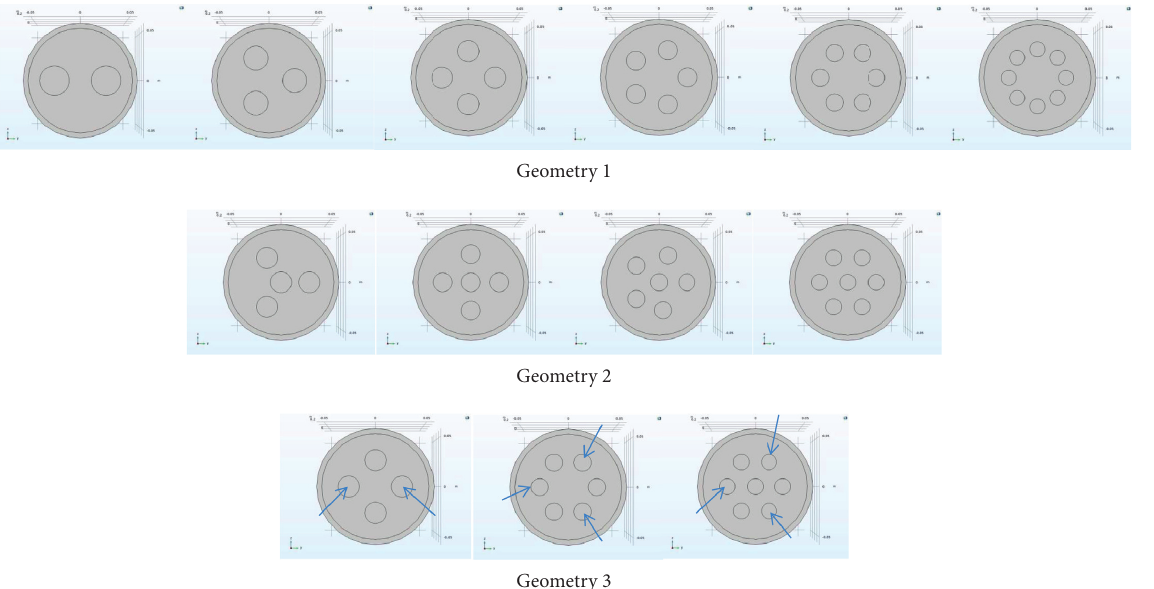
Figure 3: Frontal view of each reactor representing geometries 1, 2, and